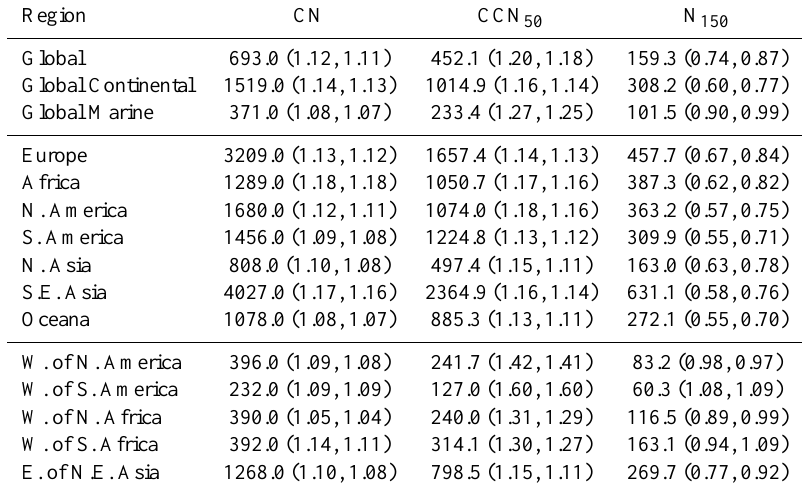
Table 1. Regional-mean annual-mean CN (all particles with D p > 10nm), CCN 50 and N 150 . GLOMAP-bin values are shown first with the ratio of mode/bin shown in parentheses (original modal settings followed by revised). Regions match those defined in Merikanto et al. (2009).